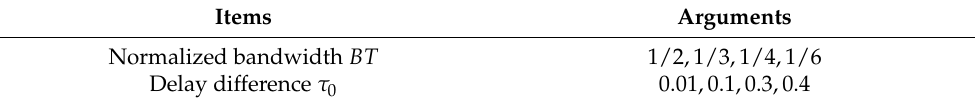
Table 1. List of simulation